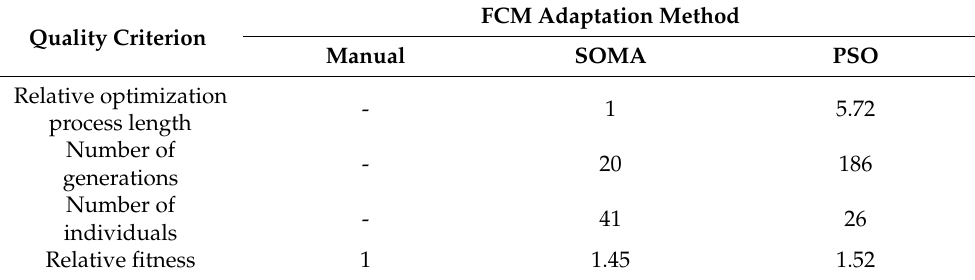
Figure 15. Comparison of turn angles for FCMs designed with help of PSO, SOMA, and manual set-up. Table 1. Quality comparison of selected FCM adaptation